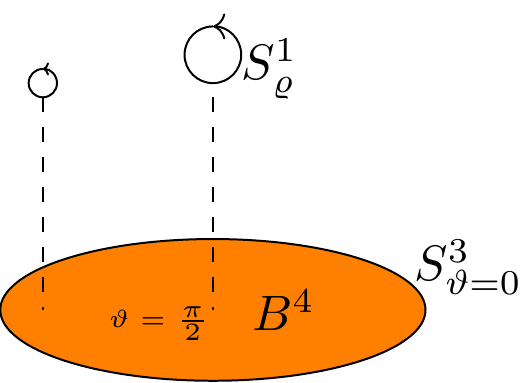
over B 4 . The S 3 of interest sits at the boundary of B 4 %